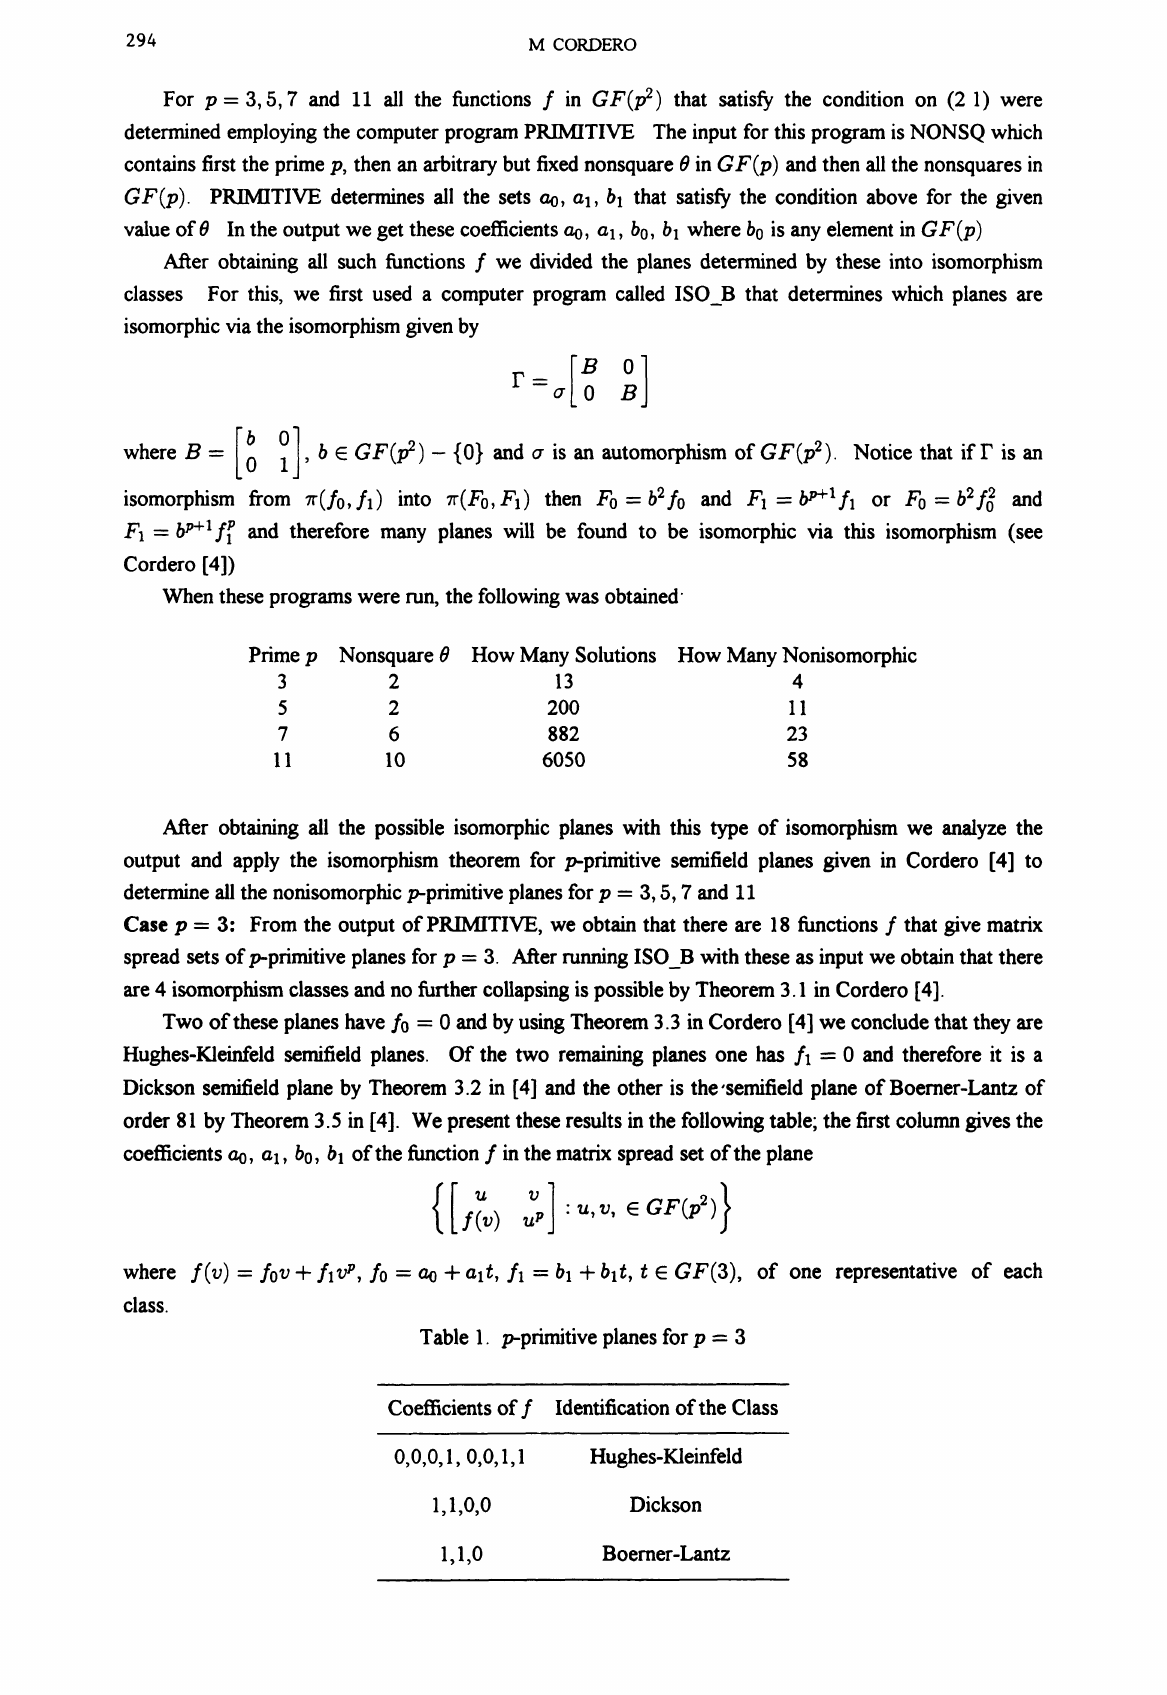
Table 1. p-primitive planes for